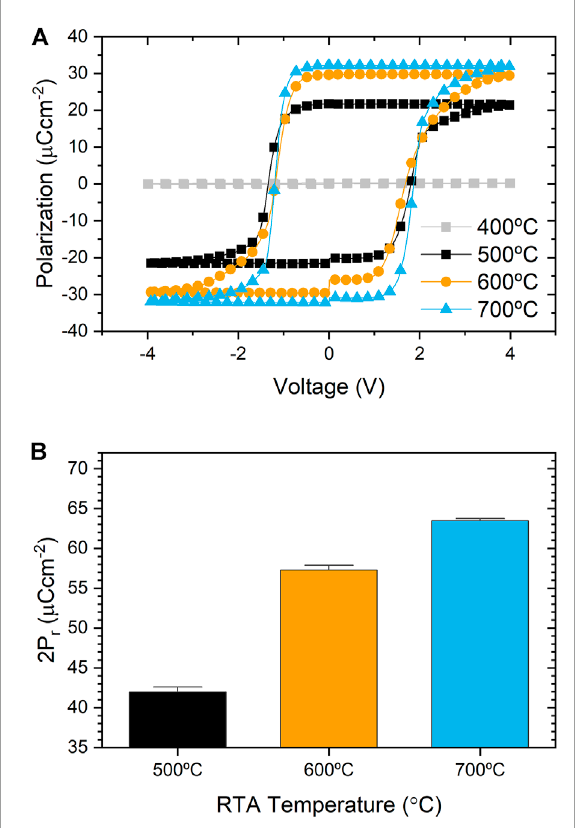
FIGURE 1 (A) Polarization-voltage plots of HZO capacitors annealed at various temperatures obtained using triangular PUND voltage scheme at 100 kHz. (B) Variation of 2P r with respect to RTA temperature. The error bars represent standard